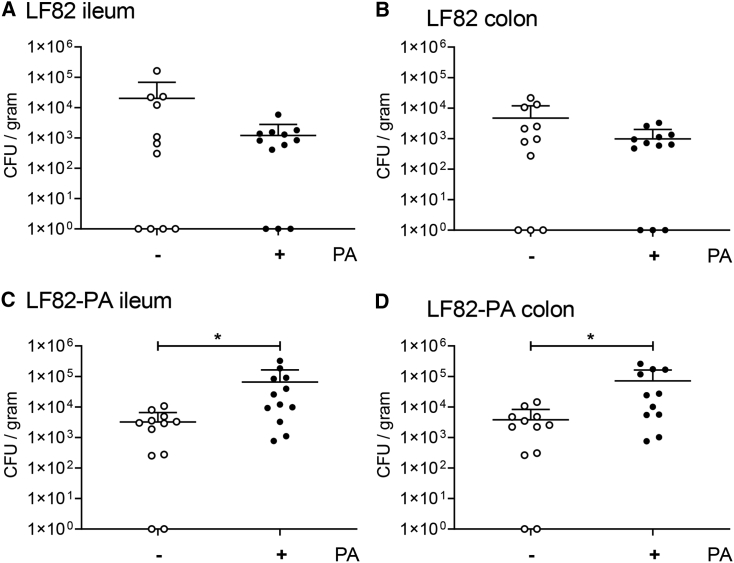
Pre-exposure of AIEC to PA Combined with Exogenous PA Supplementation Promote Colonization and Long-Term PersistenceDrinking water was supplemented where indicated with 20mM PA and provided to male C57BL/6 mice for 3 days prior to infection. Persistence of LF82 (A and B) and LF82-PA (C and D) was determined in the ileum (A and C) and colon (B and D) 21 days post-infection by colony counts. Data are expressed as CFU/gram of tissue ± SD and were analyzed using an unpaired t test (∗p < 0.05).